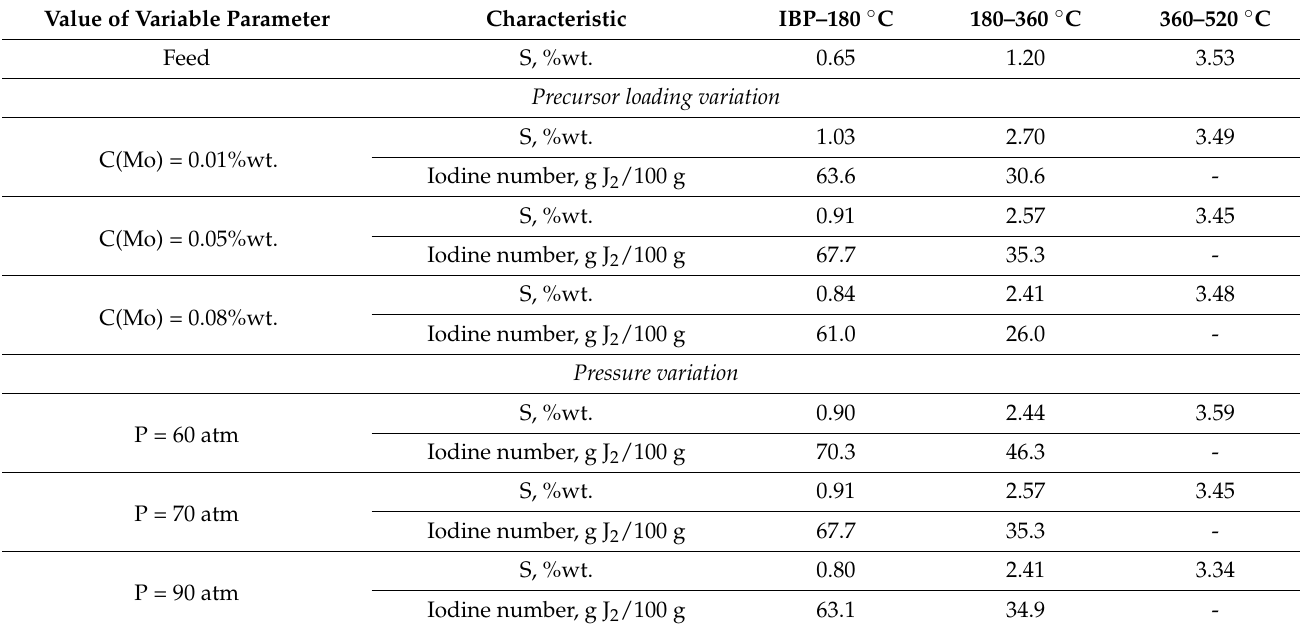
Table 3. Properties of hydroconversion